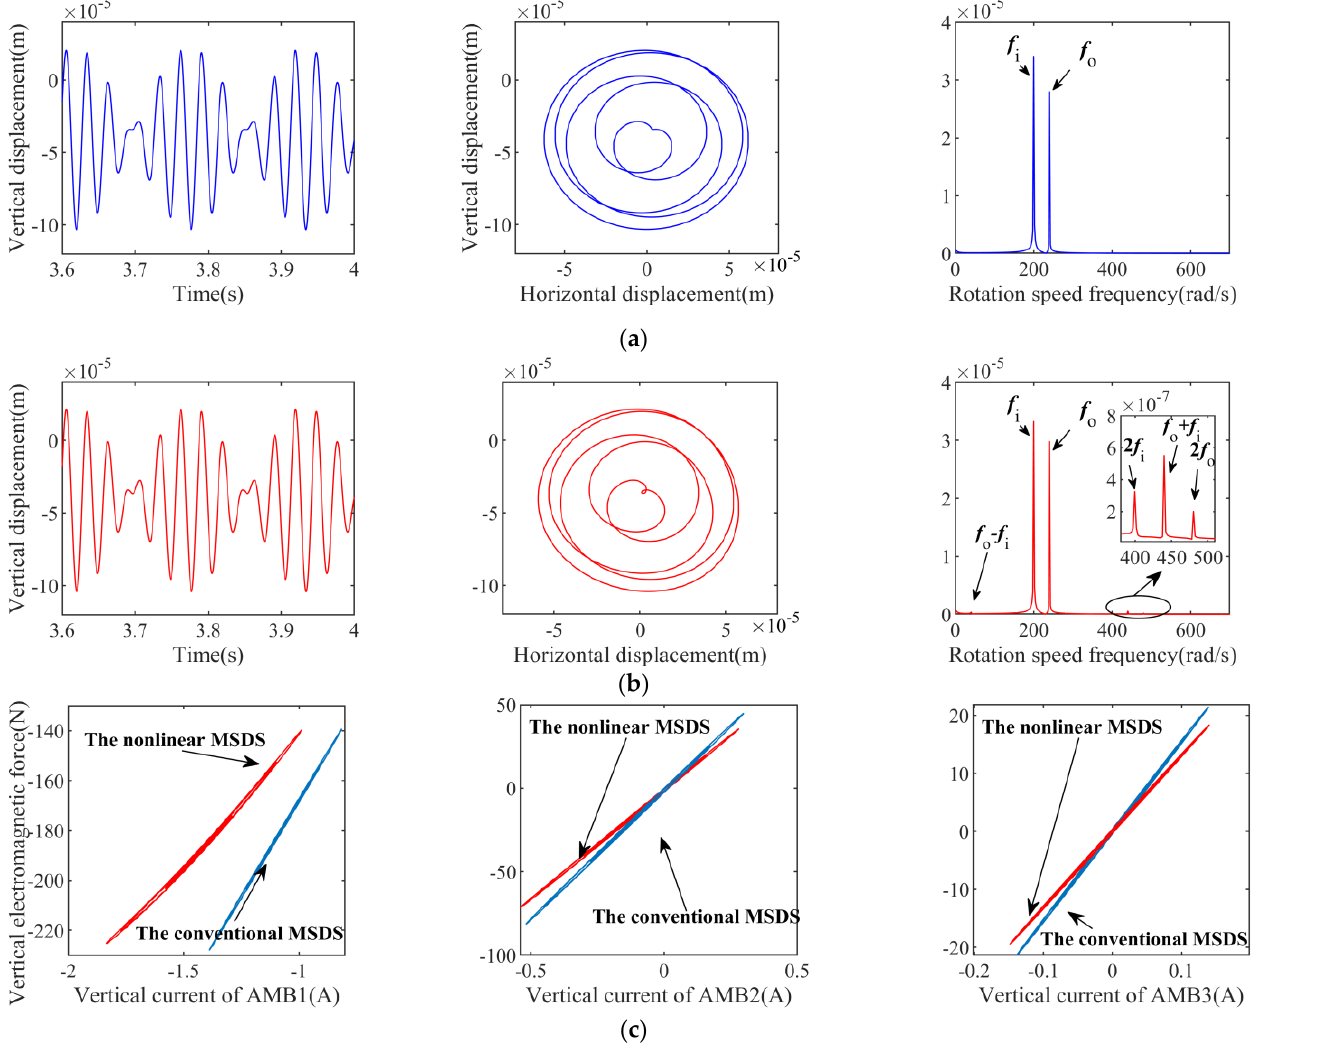
Figure 10. Unbalanced responses of the disk 1 ( ω i = 200 rad/s, F L = 200 N). ( a ) Unbalanced response of the conventional MSDS. ( b ) Unbalanced response of the nonlinear MSDS. ( c ) Bearing capacity curves of AMB 1, AMB 2, and AMB3.